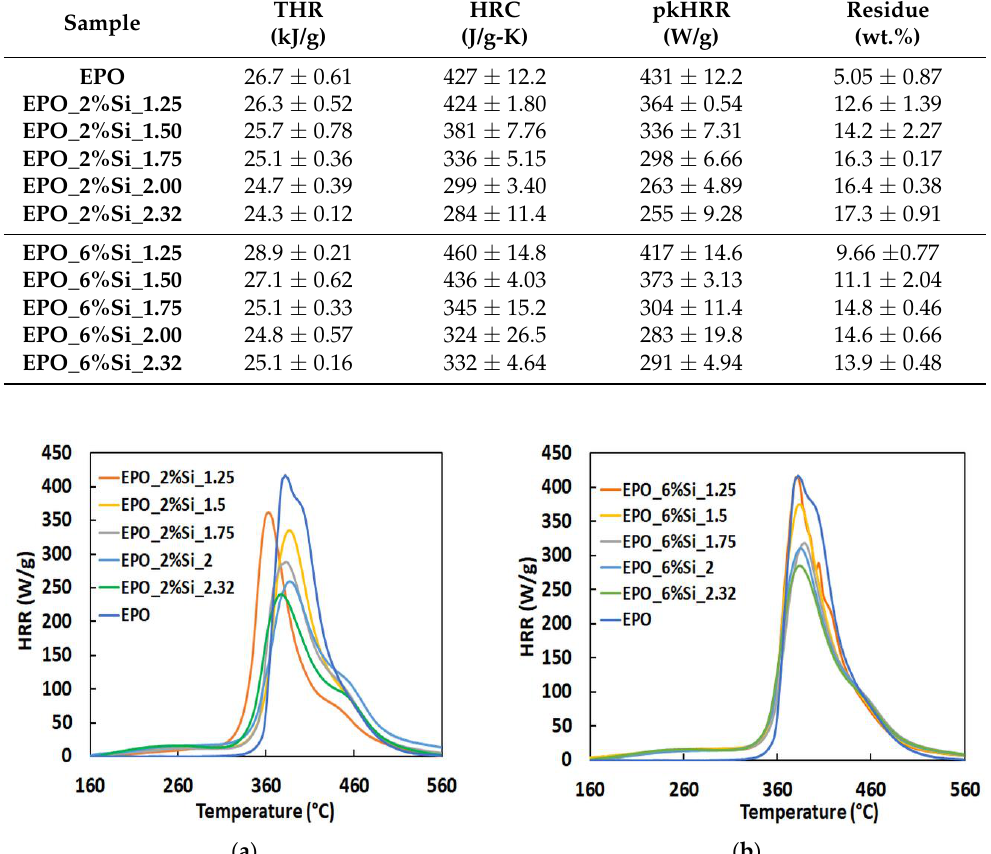
Figure 7. Typical HRR curves vs. temperature for EPO and some nanocomposites containing ( a ) 2 wt.% of silica and ( b ) 6 wt.% of silica, at different TEOS/APTS ratios. Table 5. PCFC data for epoxy samples containing 2 and 6 wt.% of silica.